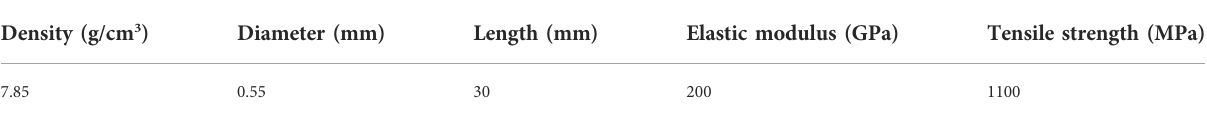
TABLE 4 Physical properties of the end hook steel fi ber.